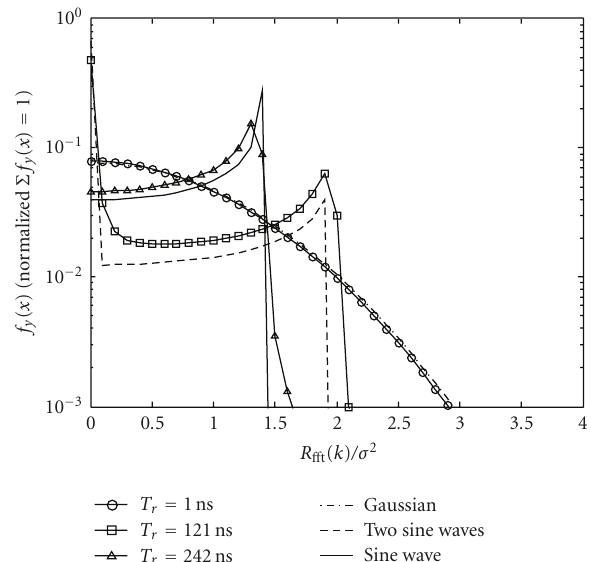
Figure 5: APD of the interfering signal after FFT in the OFDM